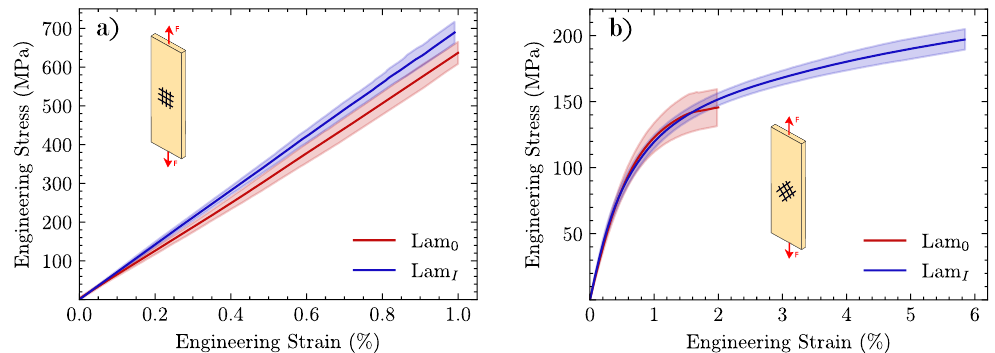
Figure 14. Stress-Strain curves comparison of the different CF/PEEK laminates tested in ( a ) 0 ◦ /90 ◦ and ( b ) ± 45 ◦ . Specimens were tested up to failure. Table 5. Tensile elastic modulus ( E ), strength ( σ f ) and strain to failure ( (cid:101) f ) for different